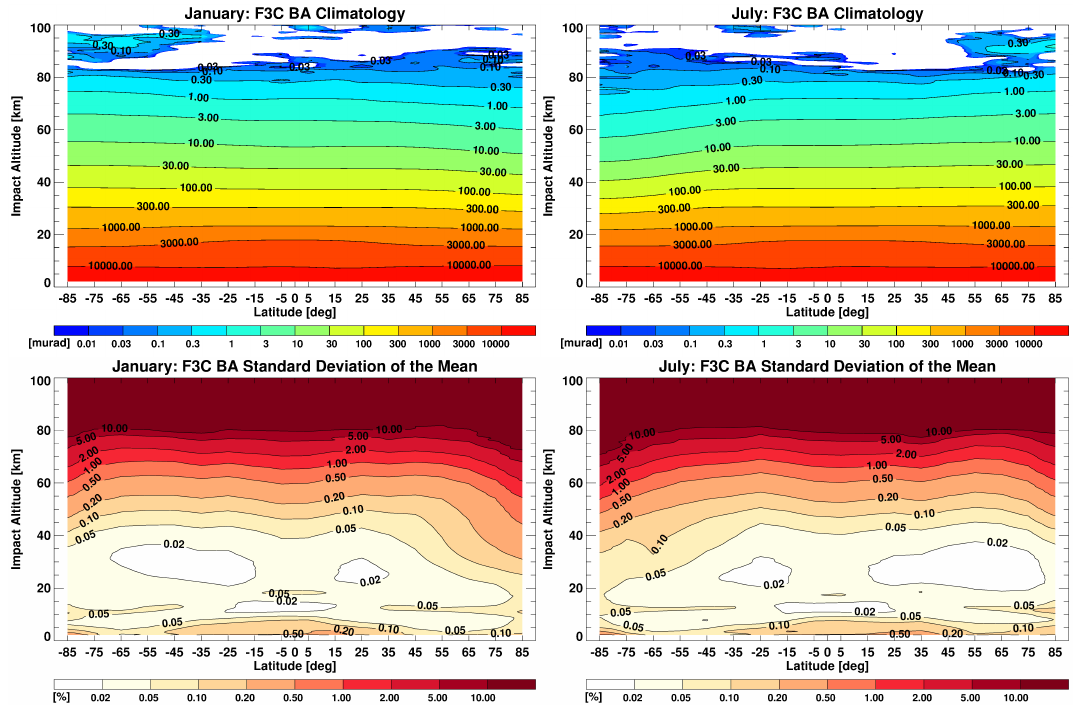
Figure 3. Mean F3C bending angles (in µrad) (top) and their standard deviation (in percent) of the mean (bottom) in January (left) and July (right) as a function of latitude and impact altitude up to